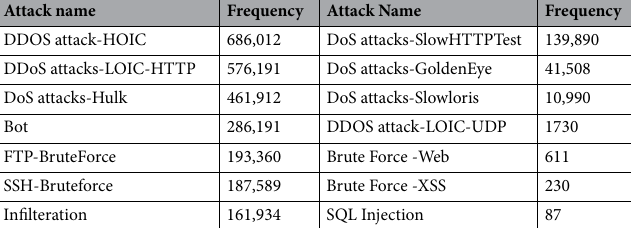
Table 3. Sample statistics of different attack types in CSE-CIC-IDS2018 dataset.